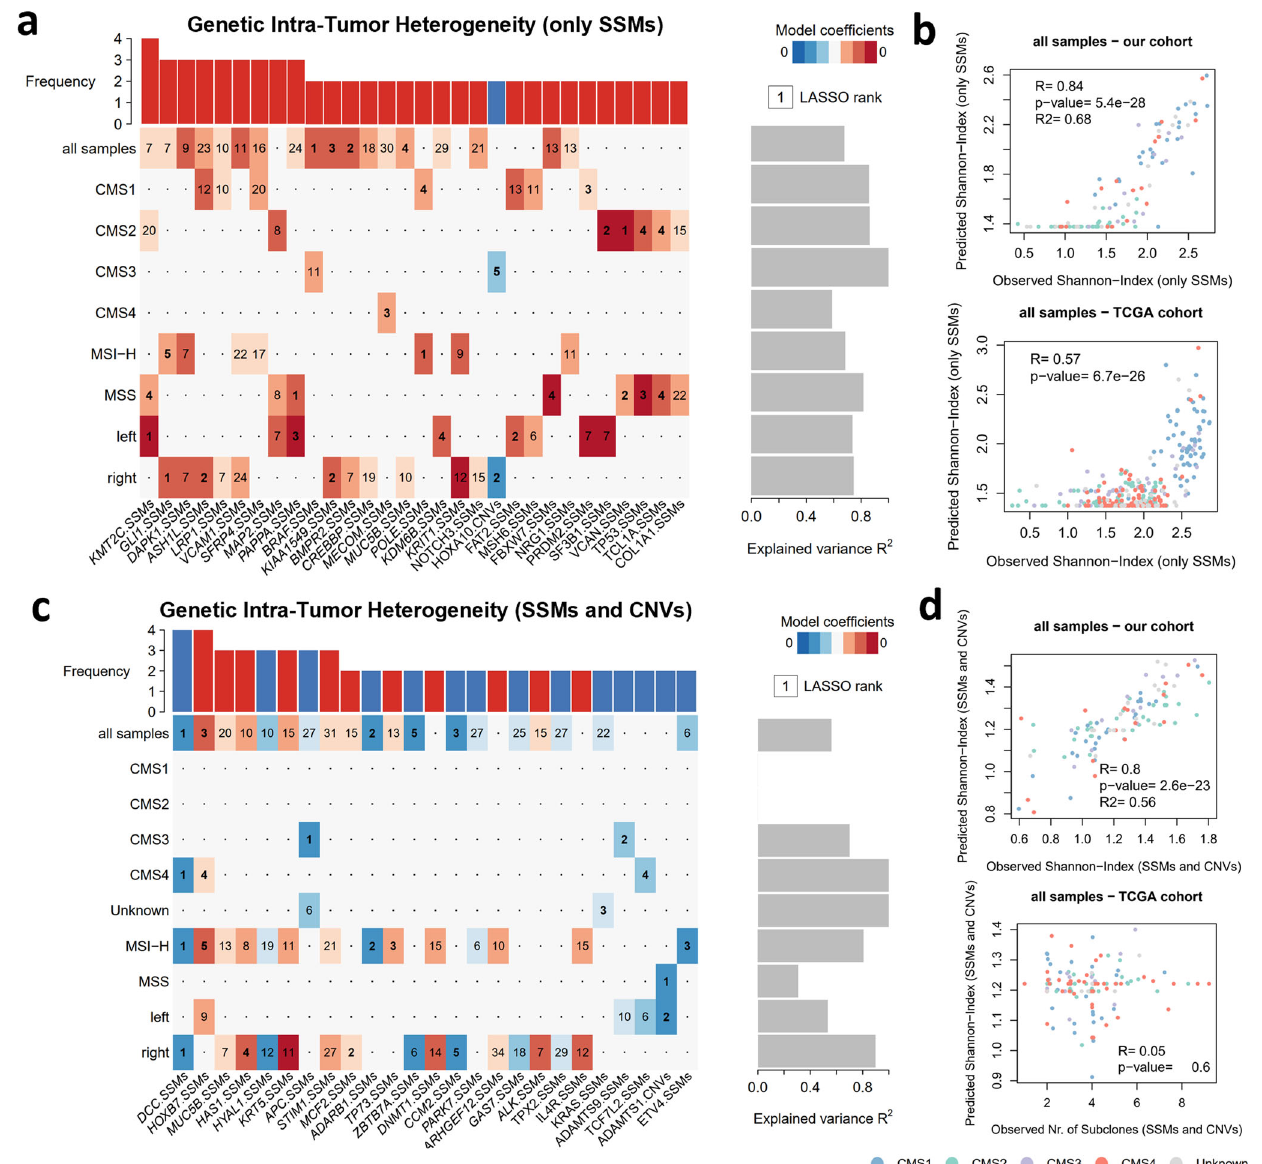
Fig. 2 Genetic biomarker signatures for genetic ITH. a Heatmap of cancer-related genes affected by SSMs or CNVs that are associated with genetic ITH levels (only SSMs) in CRC samples depicted by a LASSO penalized model. Each line represents an independent analysis applied to the CRC samples segregated according to CMS subtypes (all samples n = 112; CMS1 n = 27; CMS2 n = 36; CMS3 n = 12; CMS4 n = 19), MSI status (MSS n = 59; MSI-H n = 53) or primary tumor location (right n = 68; left n = 33). LASSO-selected coef fi cients are colored according to the effect of each standardized covariate in the optimal model. The numbers on each tile denote the order in which variables are included indicating their relative importance. The top bar plot indicates the frequency at which each driver-gene mutation occurs in the ITH fi tted model. The right bar plot shows the explained variance. b Comparison between observed and predicted genetic ITH levels (only SSMs) for all samples in our cohort and in TCGA. c Heatmap of genes with SSMs or CNVs that are associated with genetic ITH levels (SSMs and CNVs) in CRC samples depicted by a LASSO penalized model. Graphical representation similar to ( a ). d Comparison between observed and predicted genetic ITH levels (SSMs and CNVs) for all samples in our cohort and in TCGA. Colors indicate CMS subtype for each CRC sample. Estimate and statistical signi fi cance of the Pearson correlation are presented. R2 represents the explained variance of the model in our